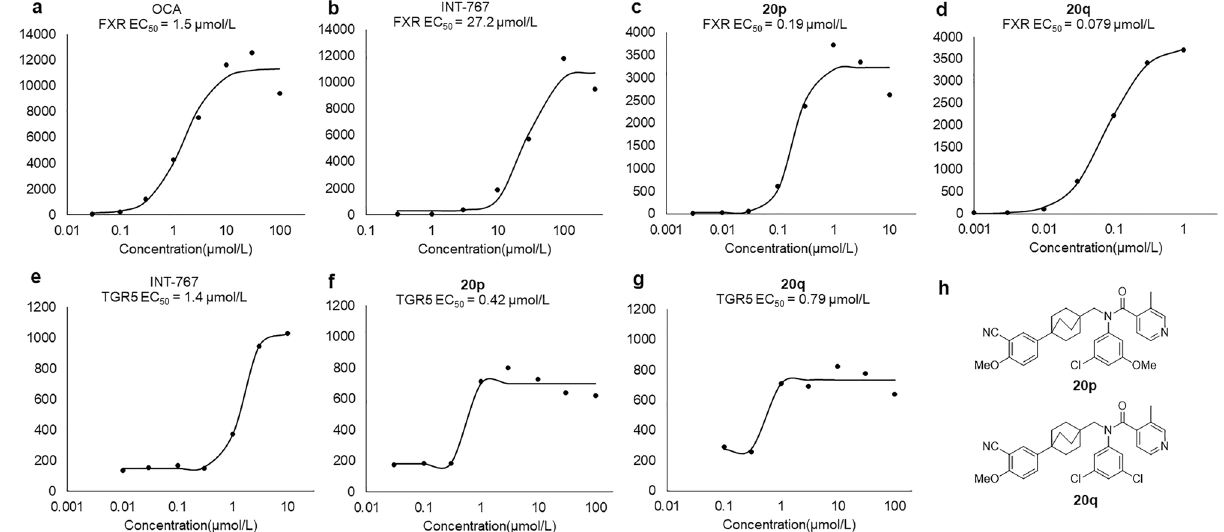
Figure 6. Concentration–response curves. (a) OCA FXR EC 50 value; ( b ) INT-767 FXR EC 50 value; ( c ) 20p FXR EC